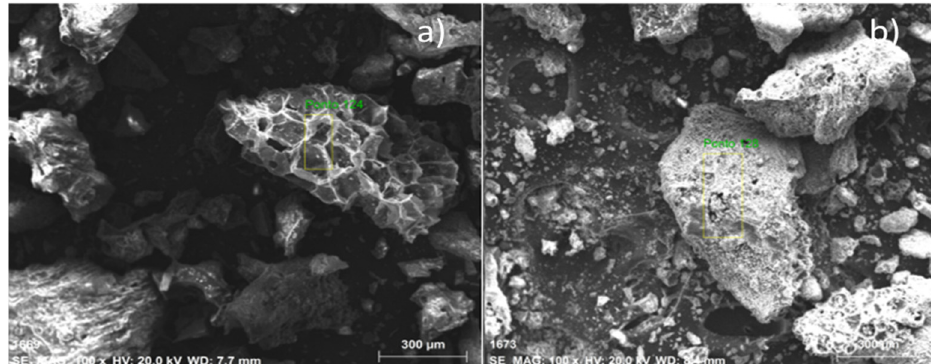
Figure 9. SEM of bio-chars obtained by pyrolysis of (organic matter + paper) fraction of MHSW at 450 °C, 1.0 atmosphere ( a ), and catalytic cracking of ( organic matter + paper) fraction of MHSW at 475 °C, 1.0 atmosphere, with 10.0% (wt.) Ca(OH) 2 ( b ) [MAG: 100× ( a ); MAG: 100× ( b )].